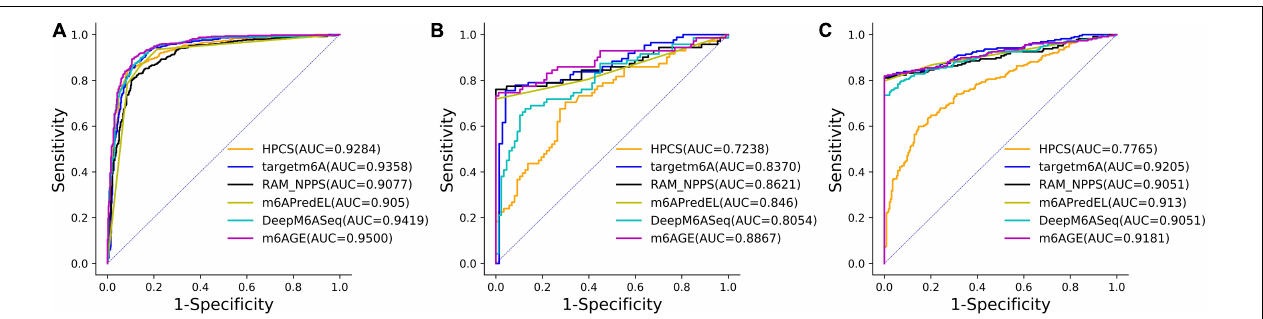
The optimal value of each evaluation metric is marked in bold.